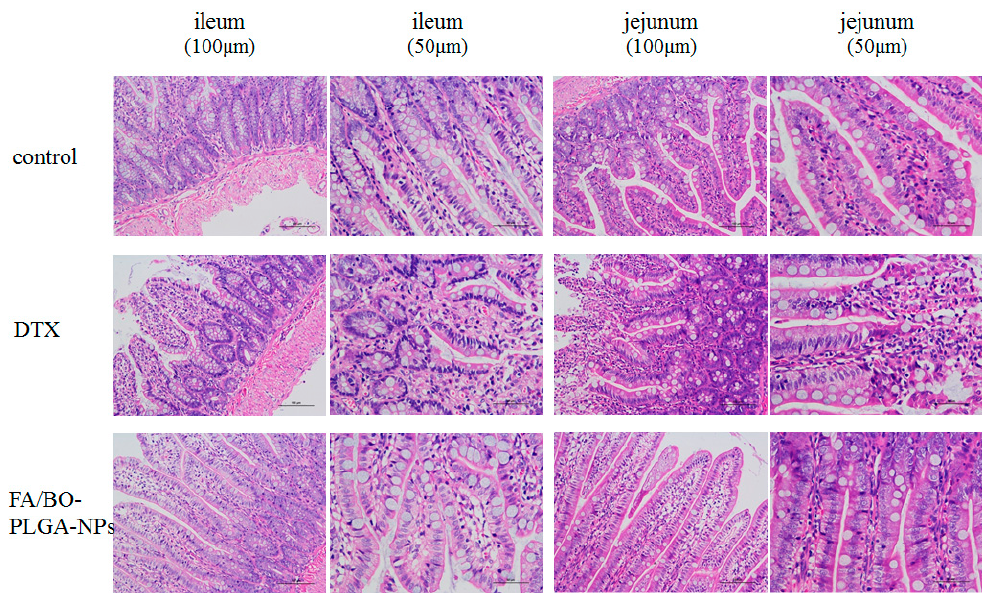
Figure 11. Histological sections of ileum and jejunum in rat’s small intestine with different scales (100 µm and 50 µm) after oral administration of no drug (control group), DTX suspension and FA/BO-PLGA-NPs under haematoxylin–eosin (HE) staining.